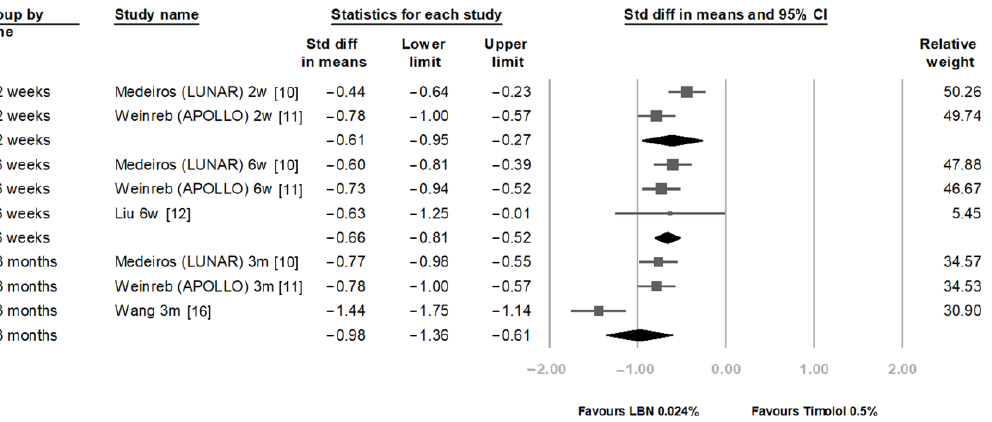
Figure 3. Comparison of IOP-lowering effect between latanoprostene bunod 0.024% and timolol maleate 0.5%.